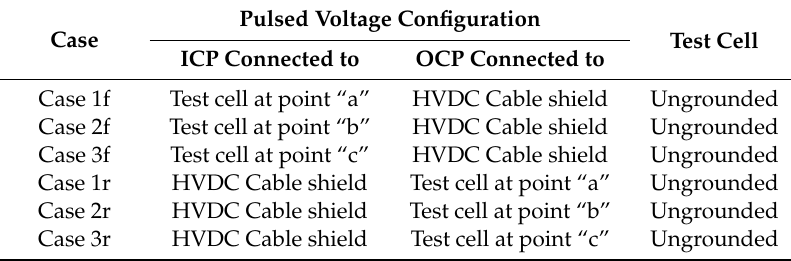
Table 2. Influence of the pulsed voltage connection test